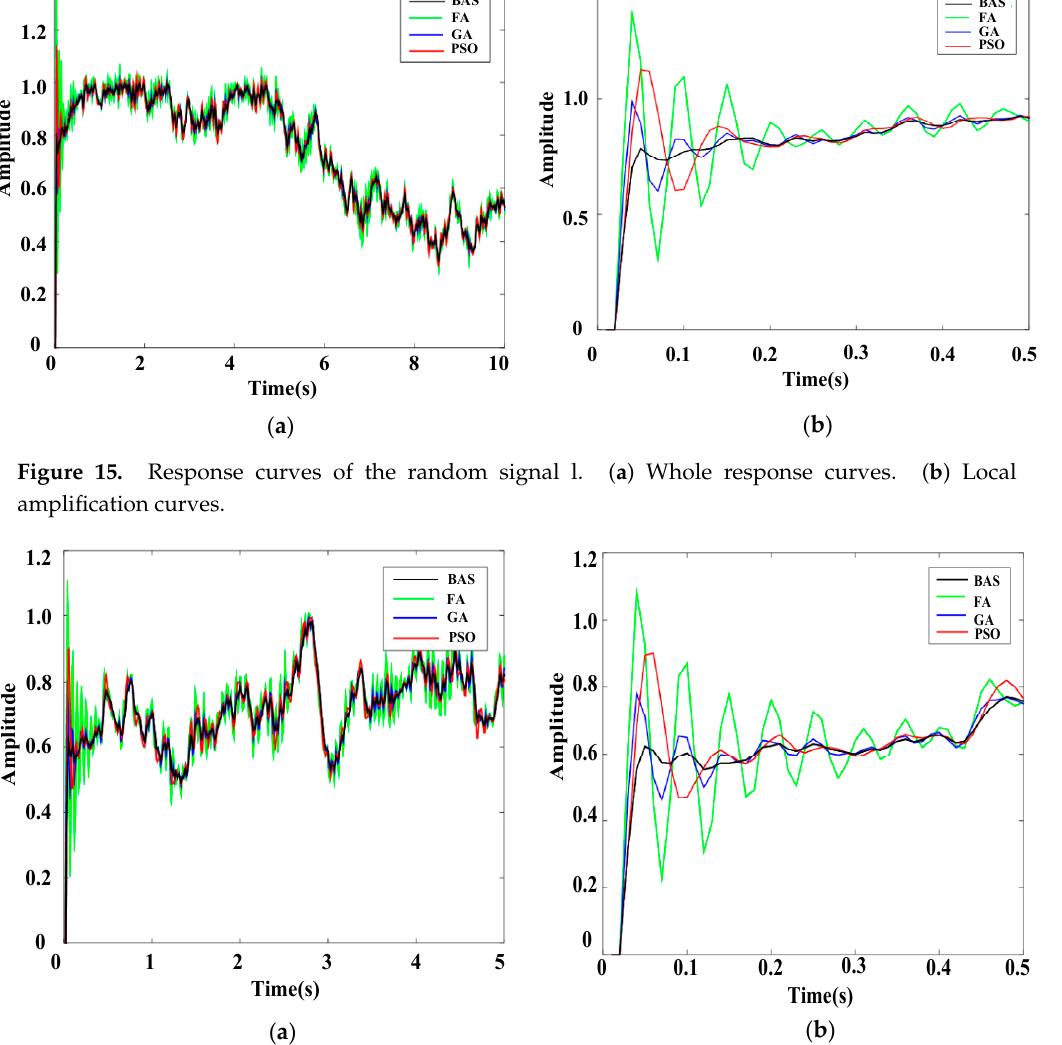
Figure 16. Response curves of the random signal 2. ( a ) Whole response curves. ( b ) Local amplification curves.